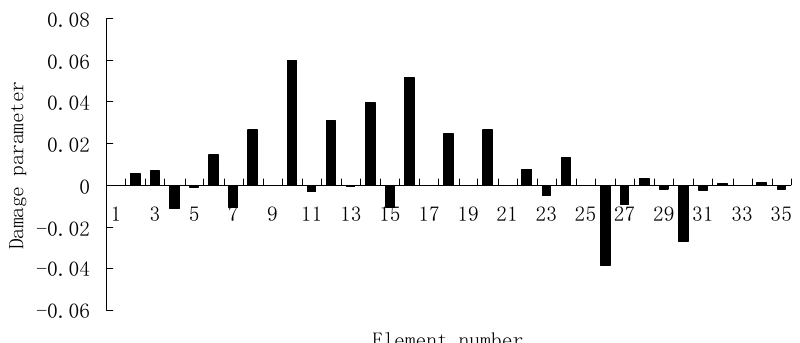
Figure 3. Damage evaluation result by the traditional SVT method for case 1 (element 10 had 20% stiffness reduction).